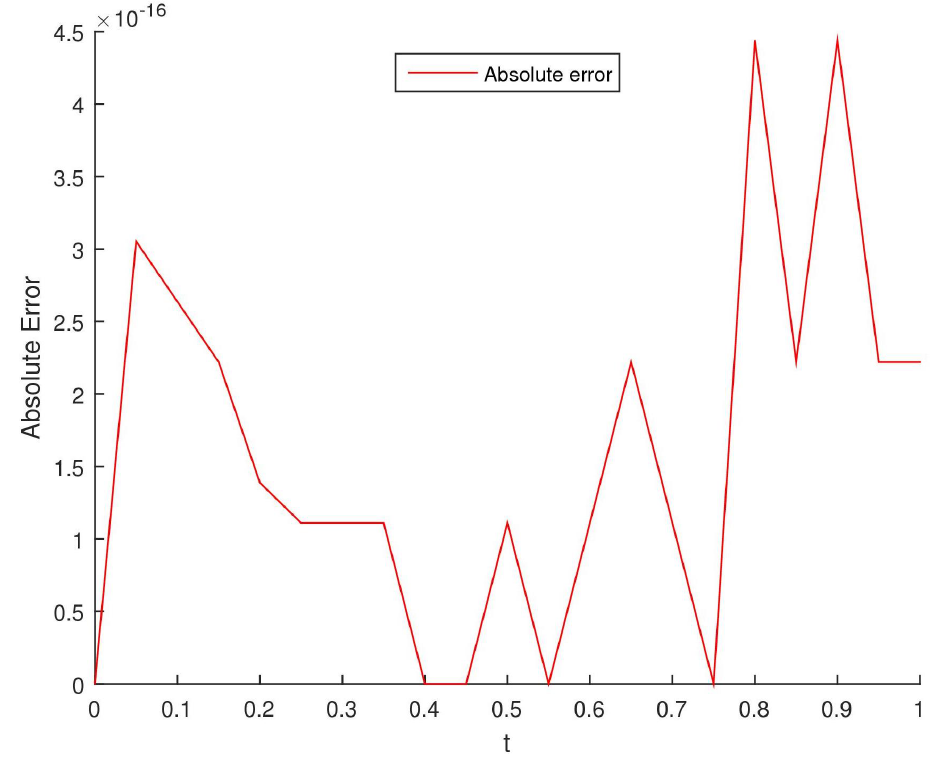
Figure 12. The acquired absolute error of the approximate solution for Example